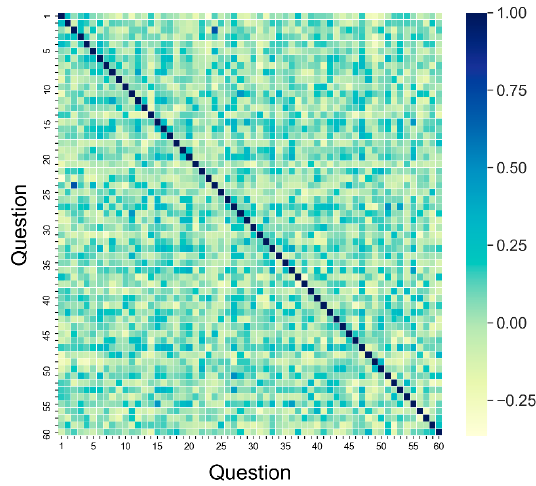
Figure 5. Correlation matrix (Pearson coefficient) for quiz answers.